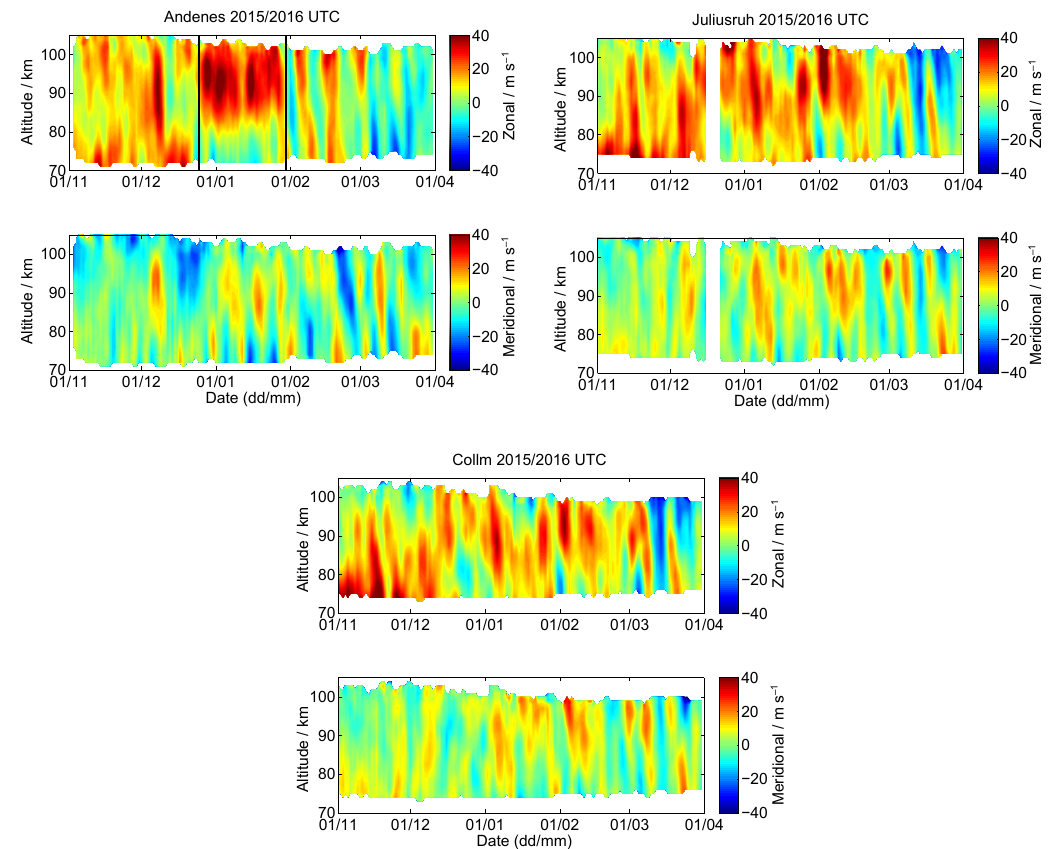
Figure 2. Zonal and meridional winds during the winter season, November 2015 until March 2016, at three different locations after the removal of potential tidal and GW contributions using the adaptive spectral filter described to decompose the time